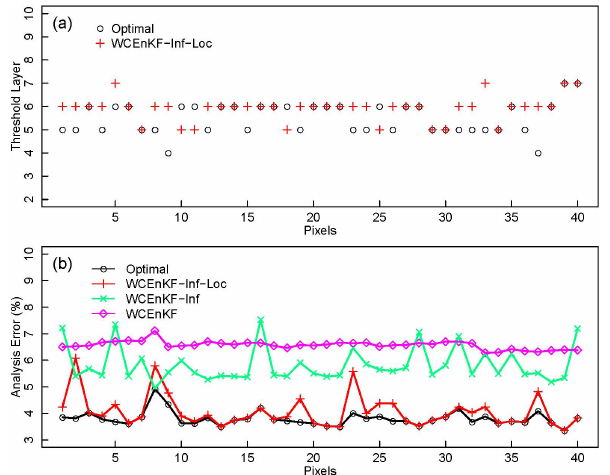
Figure 4. The threshold layers and analysis error for each pixel in the synthetic experiment. Graph (a) illustrates the optimal and WCEnKF-Inf-Loc threshold layers of each pixel. Graph (b) shows the column RSME of each pixel in different schemes with water balance constraint (Optimal, WCEnKF-Inf-Loc, WCEnKF-Inf and WCEnKF). The horizontal axes of (a) and (b) represent the 40 pix- els in the study domain.